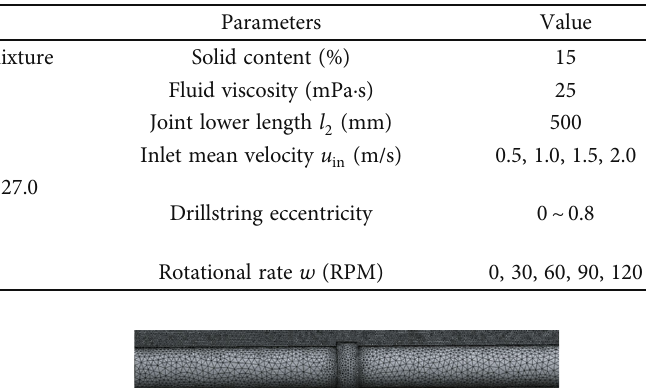
Table 1: The main CFD model parameters.